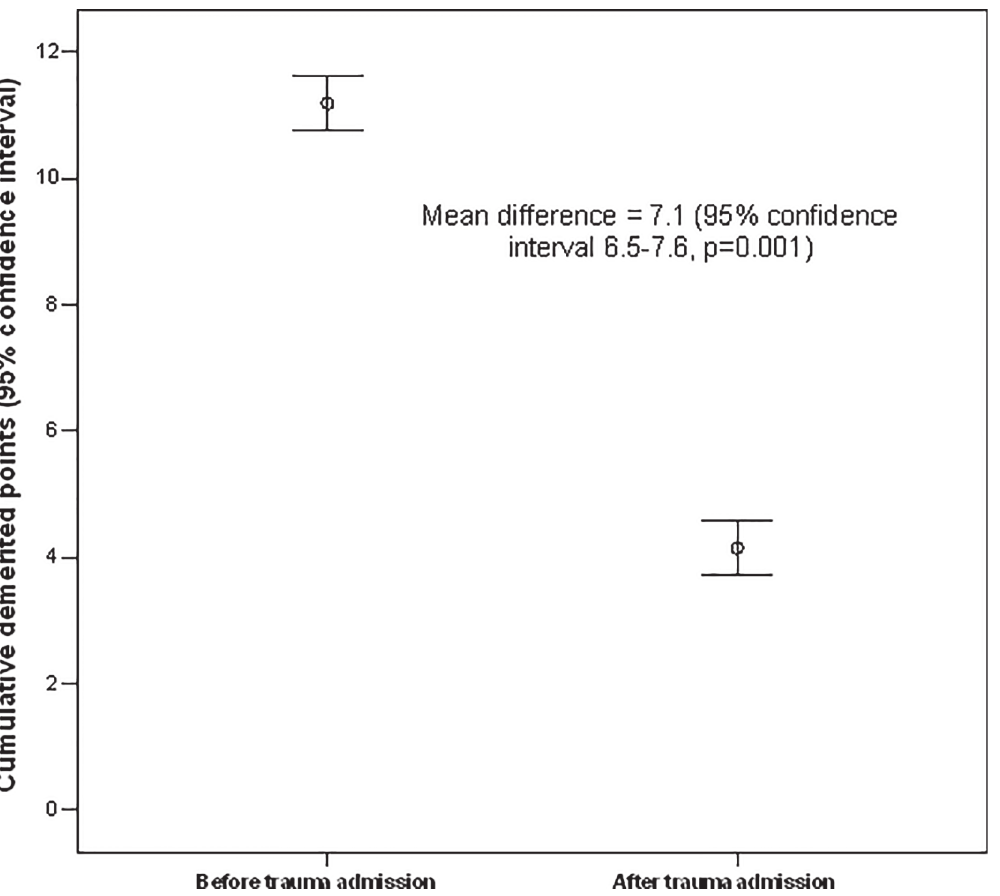
Fig 4. Differences in number of demerit points between before and after road trauma requiring intensive care unit admission. This result remained unchanged (reduction in number of demerit points = 3.7, 95% confidence interval 2.9 – 4.5, p = 0.001) after including only those with at least one traffic offence after their